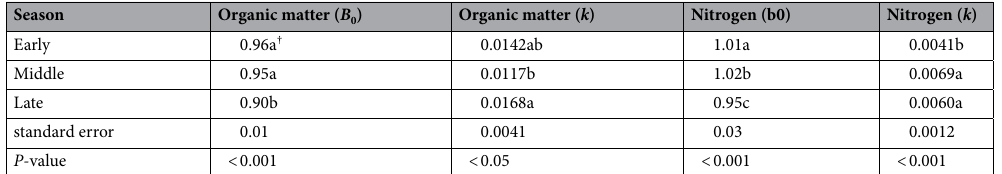
Table 2. Disappearance coefficient ( B 0 ) and relative decay rate ( k ) for organic matter and nitrogen of rhizoma peanut roots and rhizomes incubated in situ for a period of 56-days, at three different times of the year. The values represent the averages of two treatments (grazed and non-grazed) and 2 years. † Different letters within the same column are statistically different at the 5% probability